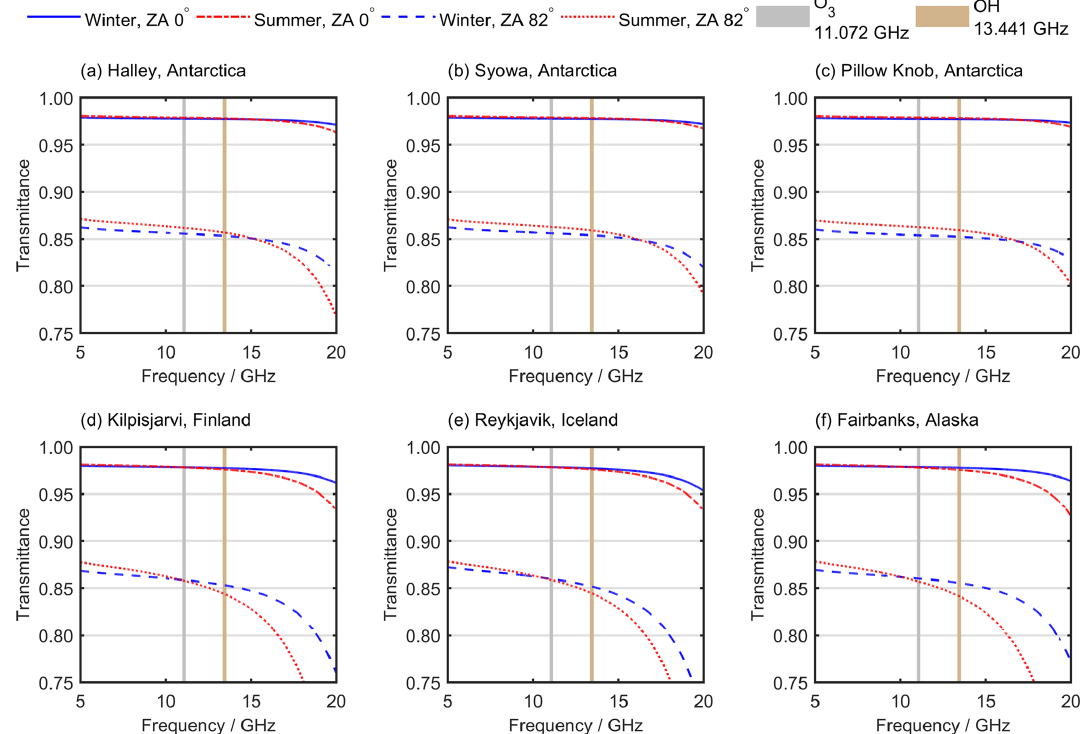
Figure 5. Survey atmospheric transmittance spectra at six polar locations for the frequency range 5–20GHz, calculated on a 1MHz frequency grid. In panels (a) – (c) transmittances calculated at zenith angles (ZAs) of 0 ◦ (i.e. viewing vertically upwards) and 82 ◦ are shown for mean summer (DJF) and mean winter (JJA) conditions at three Antarctic locations. In panels (d) – (f) transmittances calculated at ZAs of 0 and 82 ◦ are shown for mean summer (JJA) and mean winter (DJF) conditions at three Arctic locations. The light grey and light brown vertical lines indicate the frequencies of the ozone (O 3 , 11.072GHz) and hydroxyl (OH, 13.441GHz) emission lines.